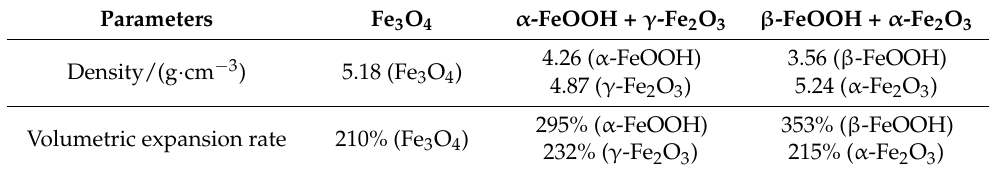
Table 1. Table of phase transformation and volume expansion rate [27] during fracture development.